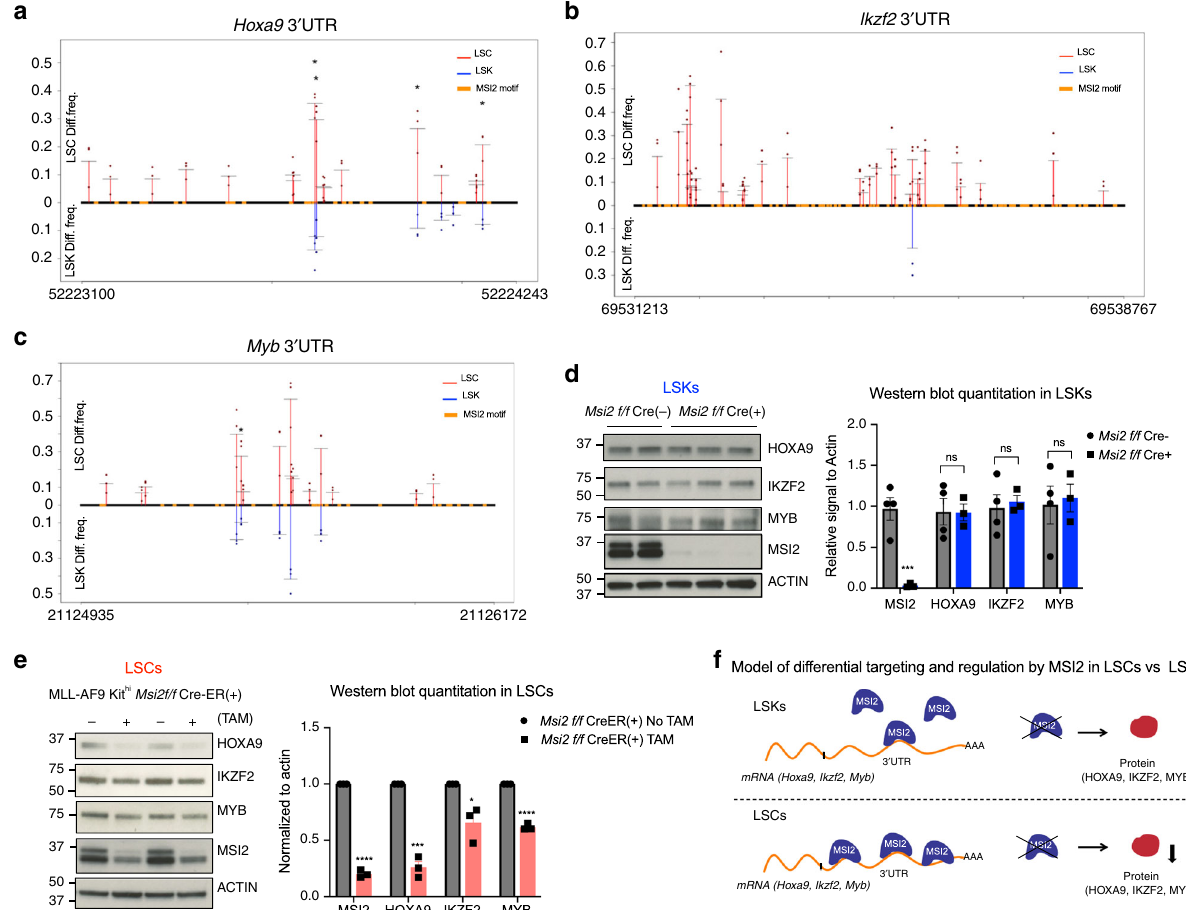
Fig. 4 Differential control of MSI2 targets in LSCs compared with normal LSKs. Diff.frequency at various sites identi fi ed by MSI2-HyperTRIBE in Hoxa9 3 ′ UTR ( a ), Ikzf2 3 ′ UTR ( b ) and Myb 3 ′ UTR ( c ) in LSKs and LSCs. Numbers on the X -axis is the start and end of 3 ′ UTR. Data presented as the mean values from three independent HyperTRIBE experiments. Signi fi cant difference is determined by beta-binomial test. * adjusted p < 0.1 d Representative immunoblot images and quantitation showing no signi fi cant change in HOXA9, IKZF2 and MYB protein expression upon Msi2 knockout in LSKs after 3 weeks of pIpC treatment in Msi2 f/f Cre( – ) and Cre( + ) mice. Each data point is an independent treated mouse. Data are presented as mean ± SEM. Two- sided unpaired Student t test. *** p < 0.005. ( p = 0.002 for MSI2). e Representative Immunoblot images and quantitation showing signi fi cant decrease in HOXA9, IKZF2 and MYB protein expression upon Msi2 knockout at 68 h after TAM treatment in MLL-AF9 Msi2 CreER( + ) LSCs. Each data point is an independent treated mouse. Data are presented as mean ± SEM. N = 6 independent experiments for HOXA9 and IKZF2, n = 3 independent experiments for MYB. Two-sided paired Student t test. ** p < 0.01, *** p < 0.001; **** p < 0.0001. ( p = 0.000002 for MSI2, p = 0.00015 for HOXA9, p = 0.019 for IKZF2, p = 0.000019 for MYB). f Schematic depiction of MSI2 elevated RNA binding and reduction of target protein expression upon MSI2 ablation in LSCs, but not in